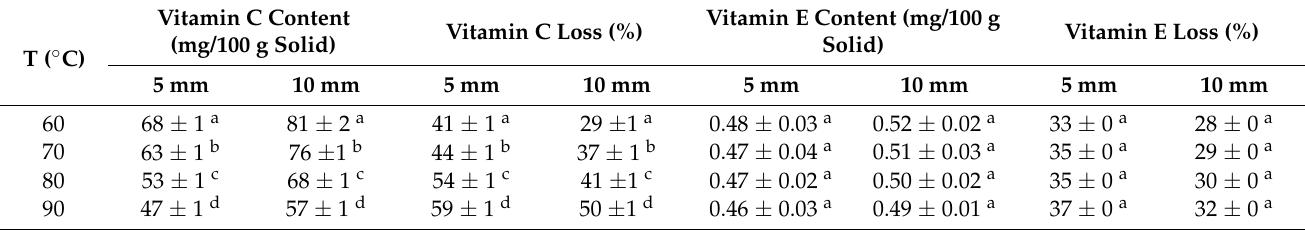
Table 4. ANOVA showed a significant effect ( p < 0.05) of temperature and sample thickness on vitamin C loss. On the contrary, temperature and sample thickness did not have a significant effect ( p > 0.05) on vitamin E losses. Table 4. Vitamin C and E content in dried Aloe vera slabs with 5 and 10 mm